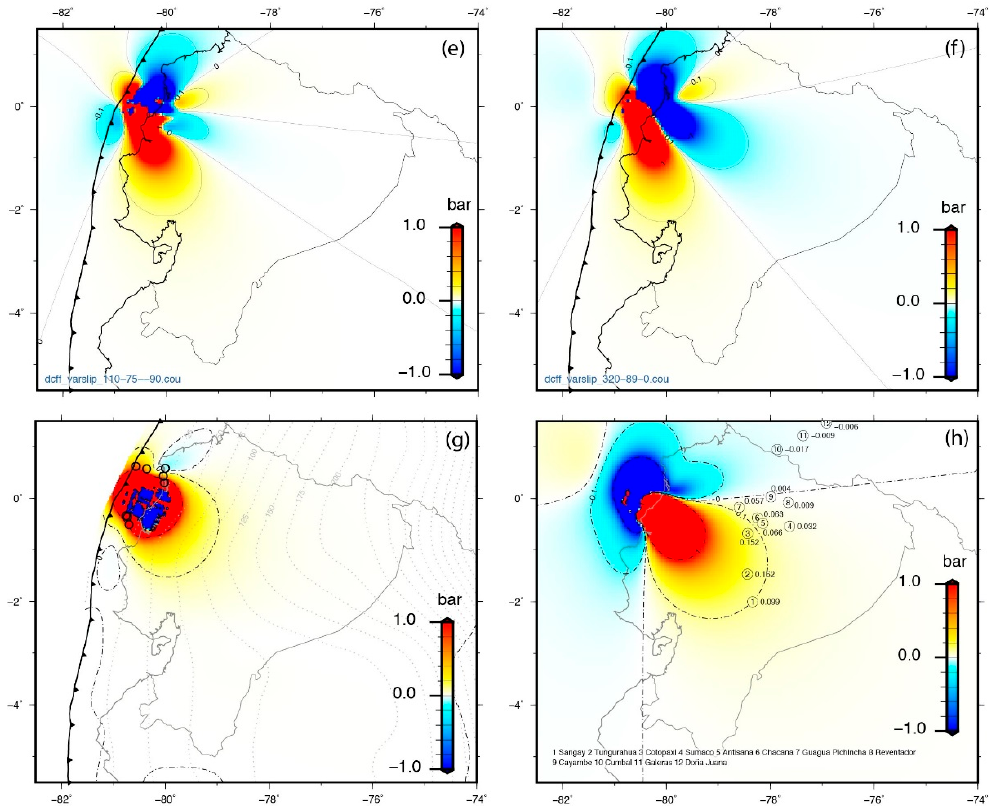
Figure 6. Coulomb failure stress changes induced by the 2016, Mw 7.8 Pedernales earthquake on: ( a – f ) different faults sets with strike-dip, rake (according to the right hand rule and the rake with the Aki and Richards convention): ( a ) N15-35,90; ( b ) N 45-85,180; ( c ) N195-35,90 ( d ) N230-75,90; ( e ) N110-75,-90; ( f ) N320-89,0; ( g ) Coulomb failure stress change on the subduction interface. Black circles indicate the location of the Mw ≥ 6 events occurred after the Pedernales earthquake; ( h ) Coulomb failure stress changes on the volcanoes, indicated by numbers 1 to 12. Models ( a – f , h ) are estimated at 10 km depth. Note that the colour scale is saturated.